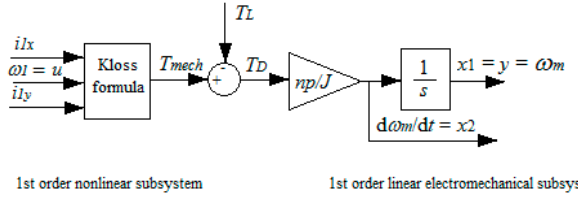
Figure 3. Simplified model of the IM presenting a 2nd order nonlinear system.